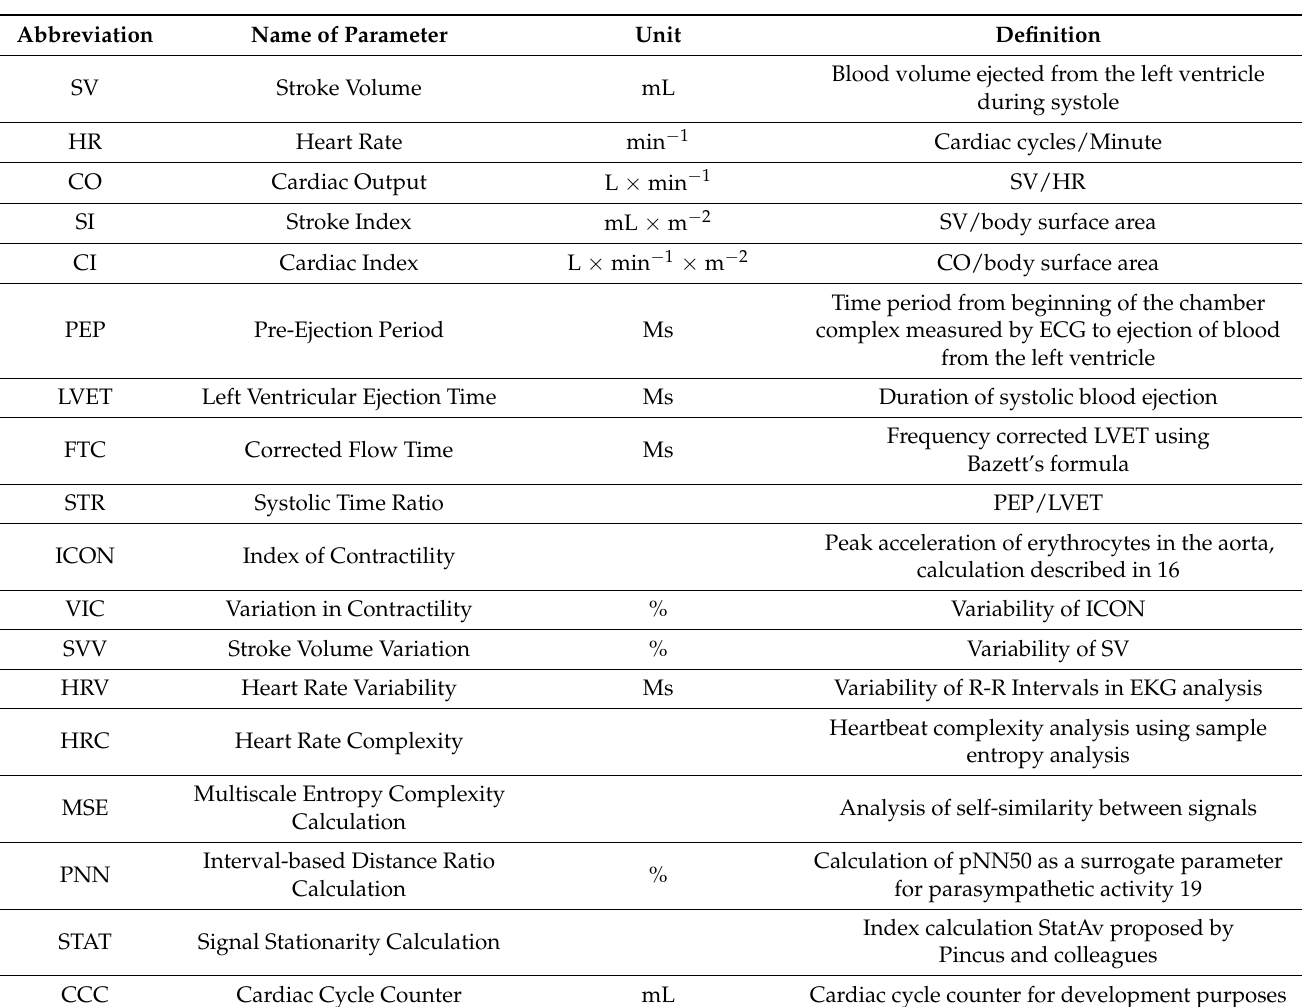
Table 1. Overview of the electrical cardiometry parameters recorded continuously by the Osypka ICON™ monitoring